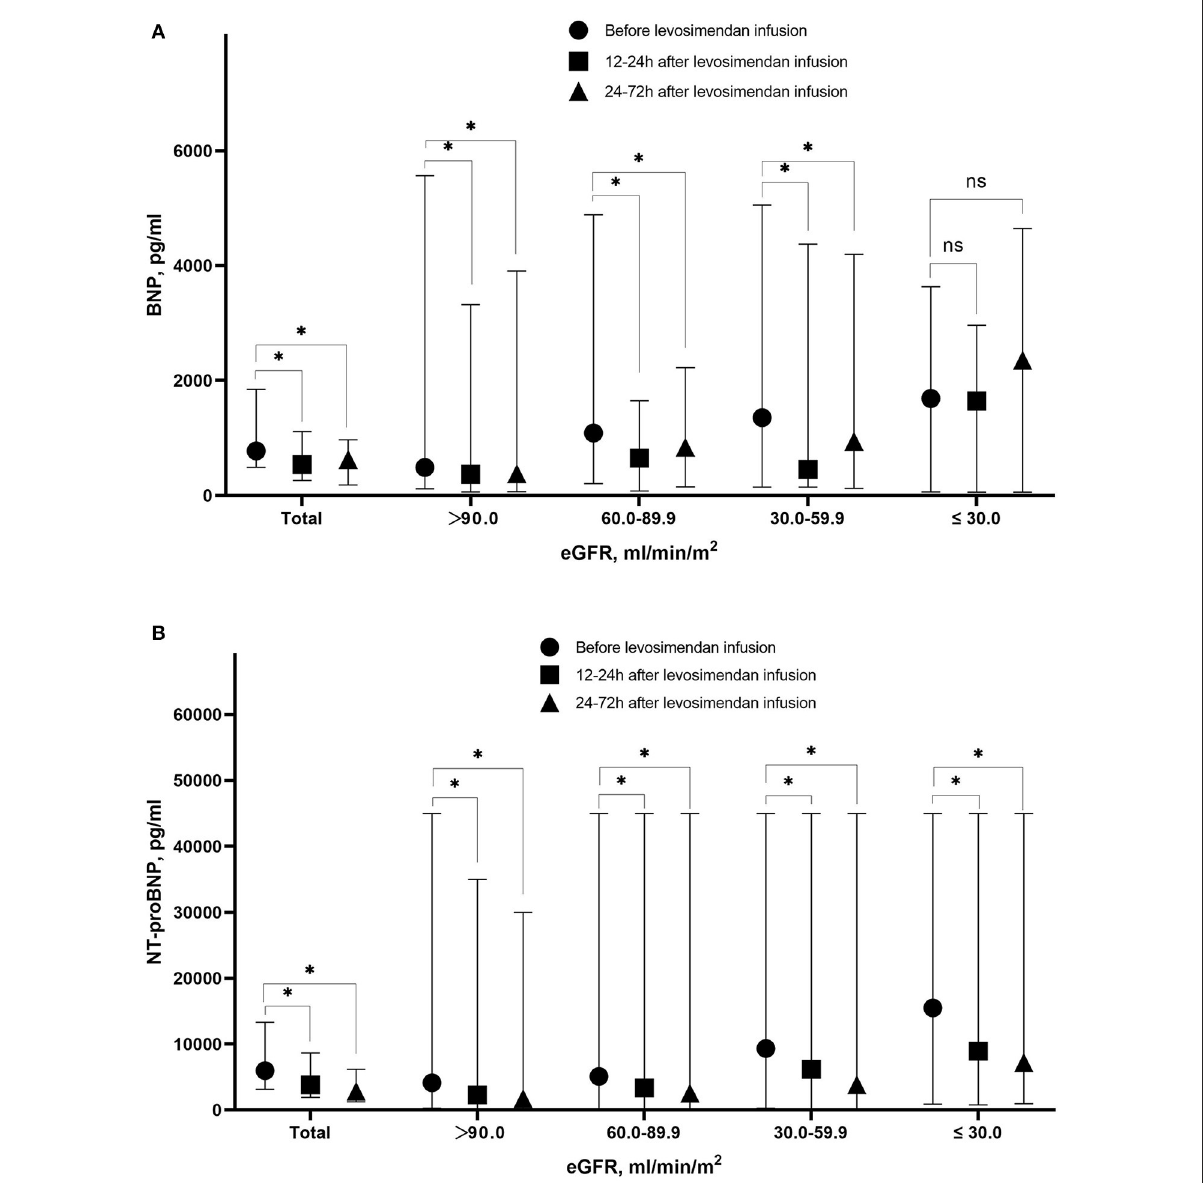
FIGURE3 Level of BNP (A) and NT-pro BNP (B) before levosimendan infusion, at 12–24h after levosimendan infusion, and 24–72h after levosimendan infusion according to eGFR level. BNP, Brain natriuretic peptide; NT-pro BNP, N-terminal pro- brain natriuretic peptide; eGFR, estimated glomerular filtration rate. * Statistically significant difference compared with eGFR level before levosimendan infusion ( p < 0.05). ns Non-statistically significant difference compared with eGFR level before levosimendan infusion ( p > 0.05).